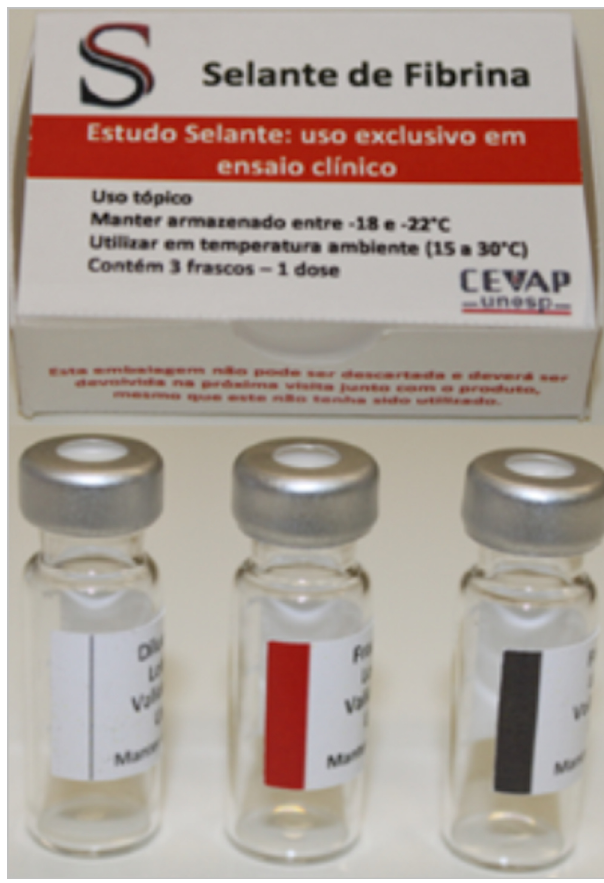
Figure 2. Package with three vials that constitutes the heterologous fibrin sealant. Diluent bottle (white stripe) containing 0.6 mL of calcium chloride; fraction 1 bottle (red stripe) containing 0.4 mL of serinoprotease from Crotalus durissus terrificus venom; fraction 2 bottle (black stripe) containing 1 mL of fibrinogen-rich cryoprecipitate and clotting factors extracted from buffaloes. This product was approved for utilization in clinical trials only.